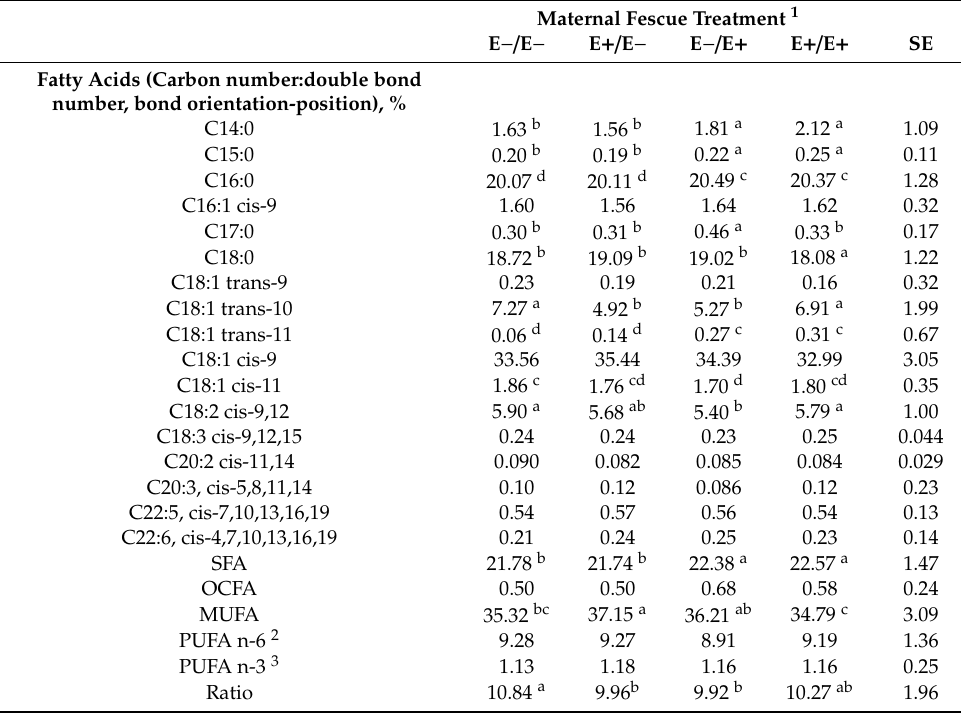
Table 6. Fatty acid composition of tissues from wethers born to ewes consuming endophyte-infected (E + ) or endophyte-free (E − ) fescue during MID (d 35-85) and LATE (d 86- parturition) gestation. Maternal Fescue Treatment 1 E − / E − E +/ E − E − / E + E +/ E + SE Fatty Acids (Carbon number:double bond number, bond orientation-position), %